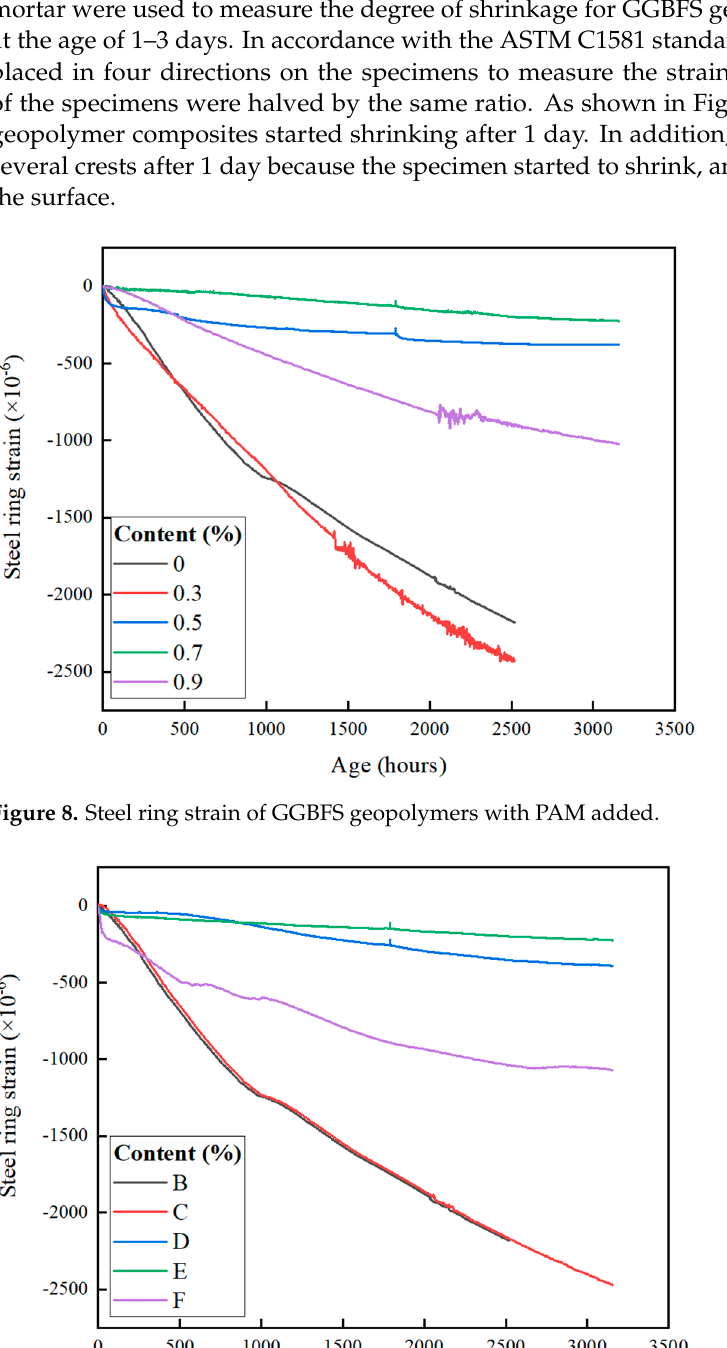
Figure 10. Steel ring strain of GGBFS geopolymers with ST added. 3.3. Weight Loss of GGBFS Geopolymers under Sulfate Acid Attacks Sulfate-containing environments affect the durability of structures and induce cracks and damage. In this study, we conducted experiments according to ASTM C1012 [43] GGBFS geopolymer specimens, which were cured for 7 and 28 days. The specimens were then soaked in a saturated sulfate solution, and the process was repeated five times. Weight loss was measured at regular intervals to determine the soundness of the speci- mens, and the results are presented in Figures 11 and 12.